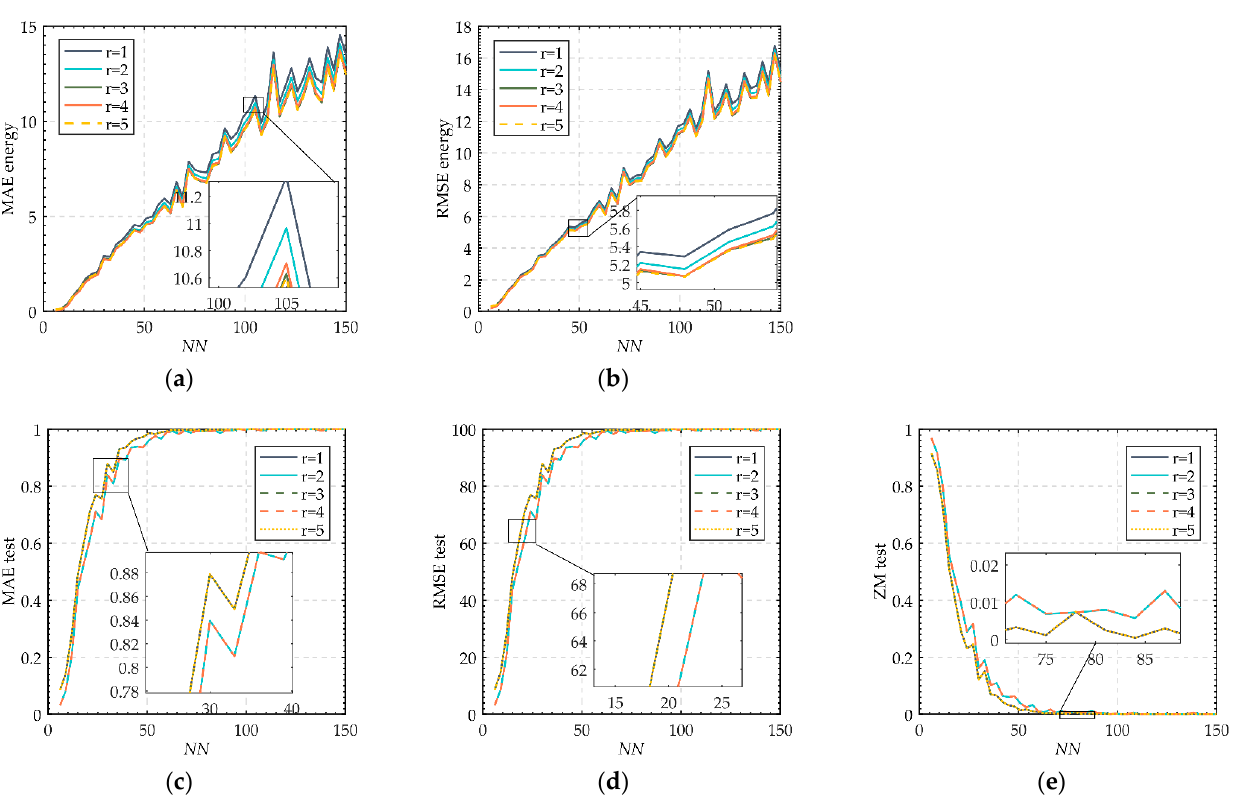
Figure 12. Error performance for ( a ) MAE energy , ( b ) RMSE energy , ( c ) MAE test , ( d ) RMSE test , and ( e ) ZM test